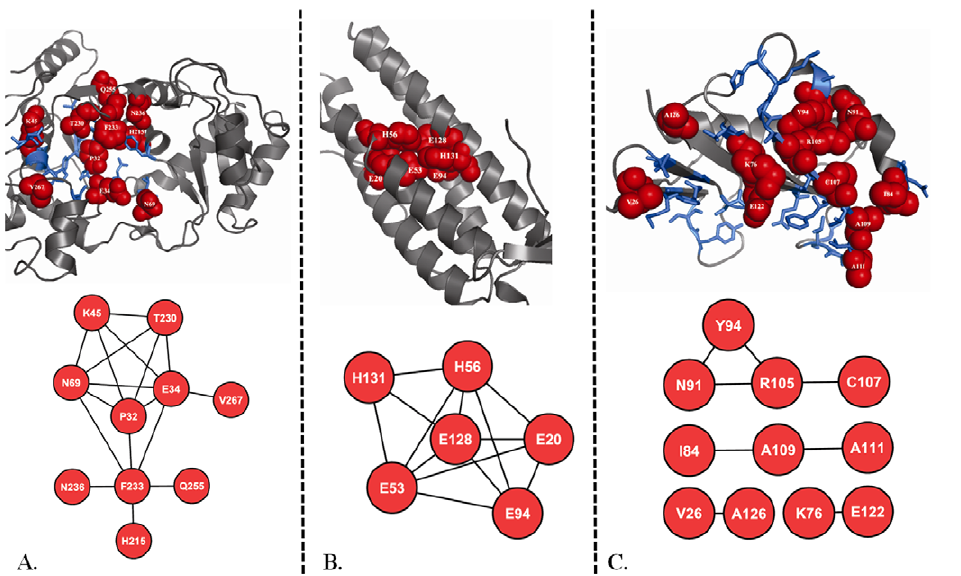
Figure 3. Examples of coevolved functional sites. Coevolved (panel A, marked in red spheres) and non-coevolved (panel A, marked in blue sticks) active sites are projected onto the structure of a representative member (PDB code: 1EUQ) from Glutamyl-tRNA synthetase(GluRS)/Glutaminyl- tRNA synthetase (GlnRS) catalytic domain family (CDD code: CD00418). Here an edge connects two coevolved residues (red circles). Coevolved metal binding sites (panel B, marked in red spheres) are projected onto the 3D structure of a representative member (PDB code: 1LKO) from ferritin-like diiron-carboxylate protein domain family (CDD code: CD00657). Coevolved (panel C, marked in red spheres) and non-coevolved (panel C, marked in blue sticks) protein binding sites are projected onto the structure of a representative member (PDB code: 1JD1) from YjgF_YER057c_UK114_family (CDD code: CD00448). Protein structural and network representations were created using the PyMol [47] and Cytoscape [48] program.